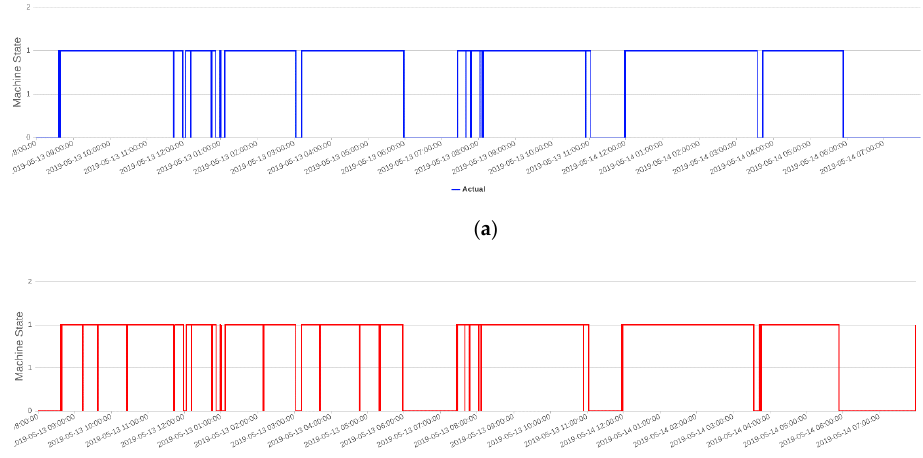
Figure 9. Comparison of the actual and predicted results of the support vector machine (SVM). ( a ) Actual machine states (in every second). ( b ) Predicted machine states (in every second) using linear SVM.